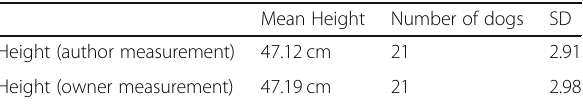
Table 8 Comparison of height measurement results between measurements taken by owners and the lead author using the stick measurement technique